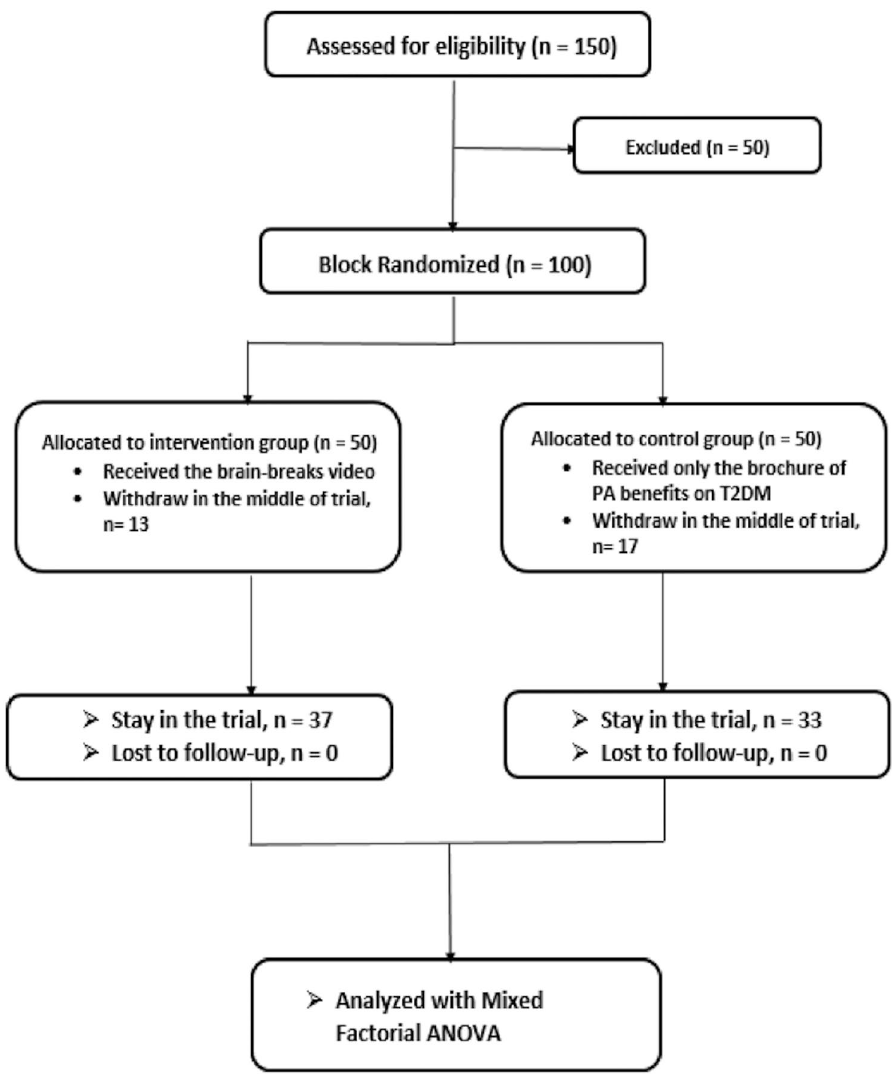
Figure 1. Participants’ group allocation